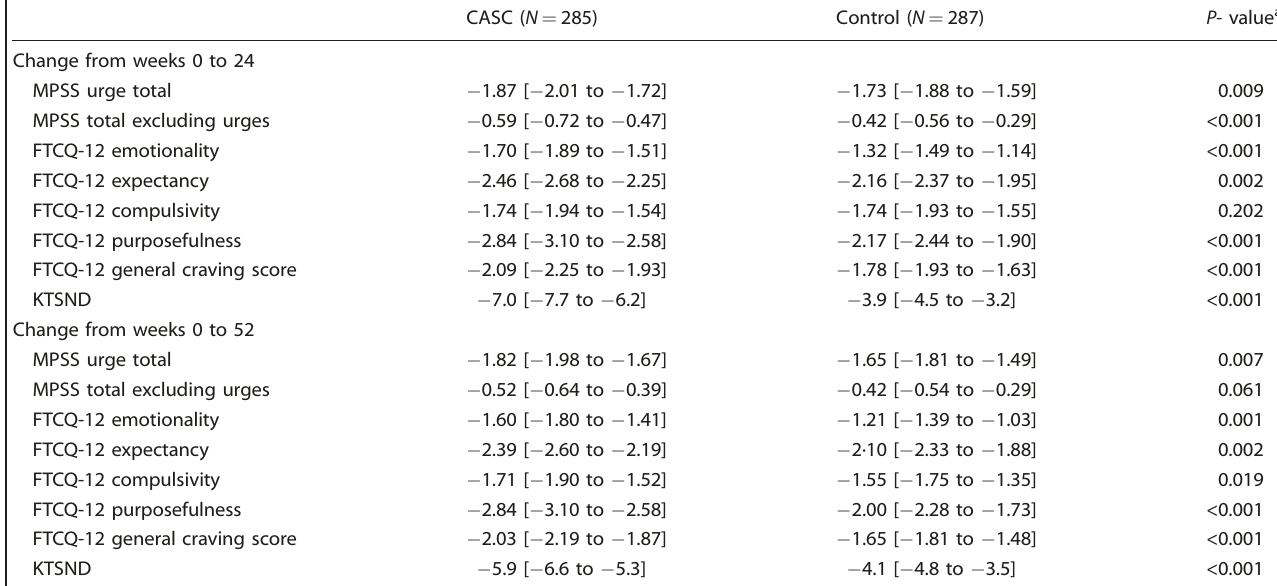
Table 2. Changes in MPSS, FTCQ-12, and KTSND scores from baseline to weeks 24 and 52, adjusted by